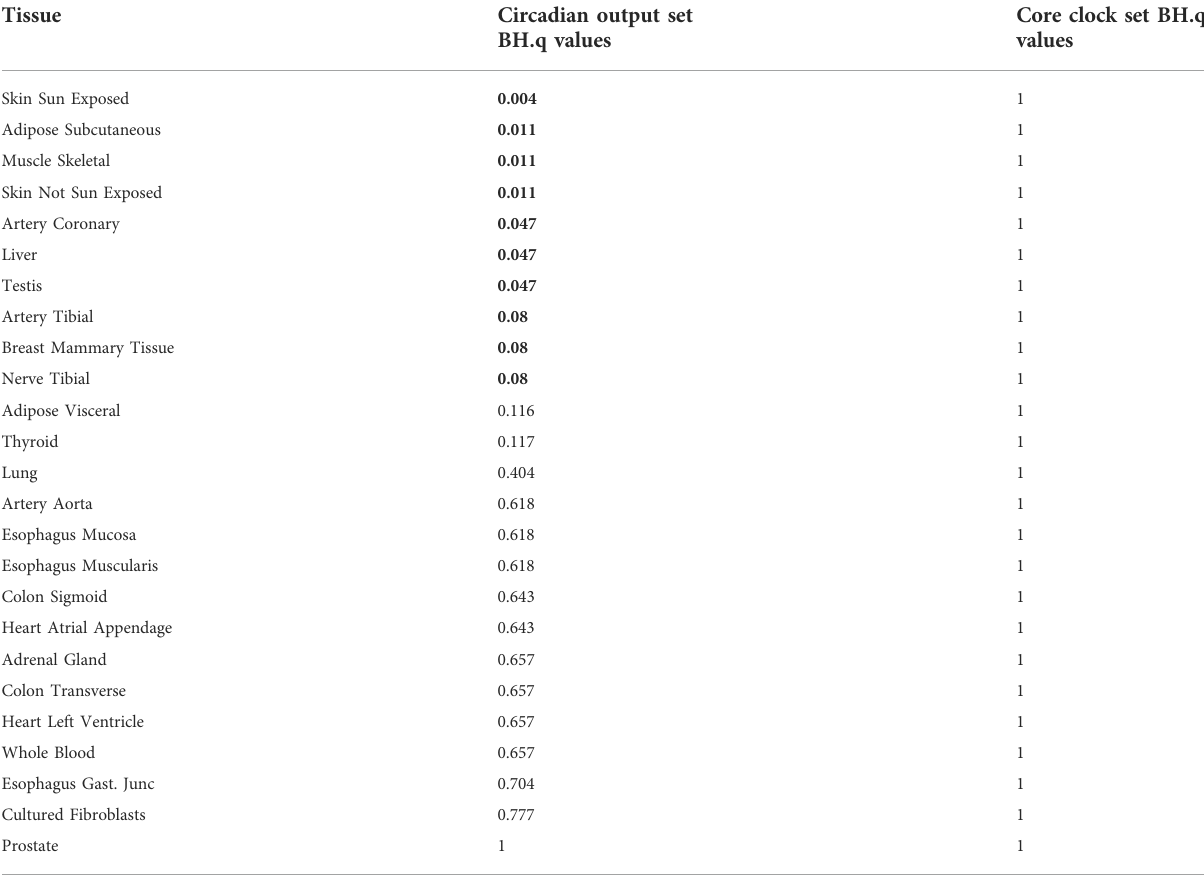
TABLE 3 Overexpression analysis of core clock and circadian output pathways in IC affected